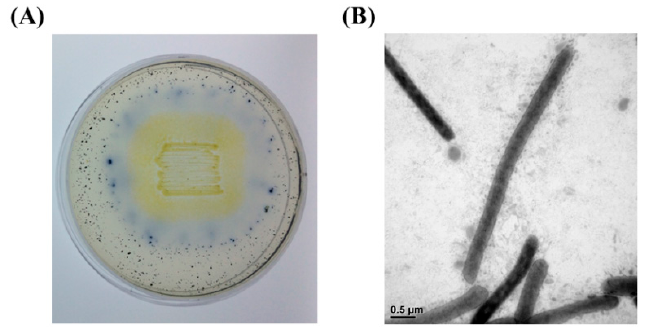
Figure 1. Characteristic features of the bacterial isolate, J9-3. ( A ) Detection of cellulase activity on Marine Agar plate containing AZCL-cellulose; ( B ) scattering electron microscopy of J9-3 cells after staining with 1% phosphotungstic acid.